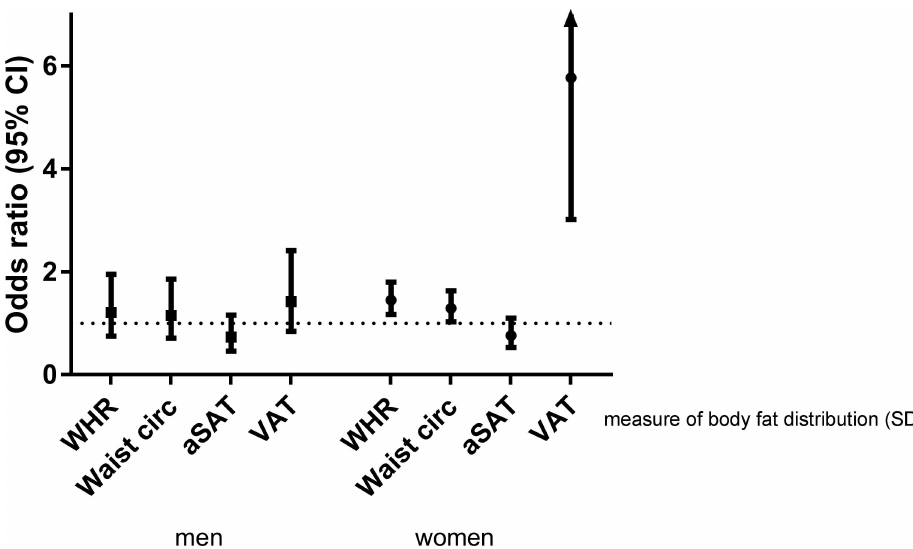
In men, the associations of the measures of body fat distribution and cardiometabolic risk factors were much weaker than in women or even absent. In women one SD higher VAT (64.0 cm 2 ) was associated with an OR of 5.77 (95% CI: 3.02, 11.01) on having at least one cardiome- tabolic risk factor, while in men one SD higher VAT was associated with an OR of 1.42 (0.84, 2.41) on having at least one cardiometabolic risk factor. (p-value interaction: 0.002) In men, WHR (OR: 1.21; 95%CI: 0.75, 1.95), waist circumference (1.15; 0.71, 1.86) and aSAT (0.73; 0.46, 1.16) were not associated with an increased cardiometabolic risk.